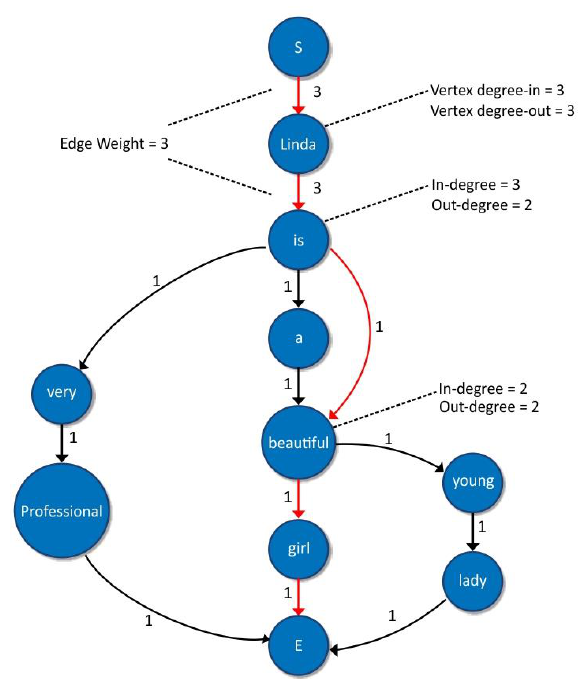
Figure 5. Word graph construction from the sentences “Linda is a beautiful girl”, “Linda is a beautiful young lady”, and “Linda is very professional”. The shortest path is the summary of these sentences in the red highlighted path saying, “Linda is beautiful girl”.